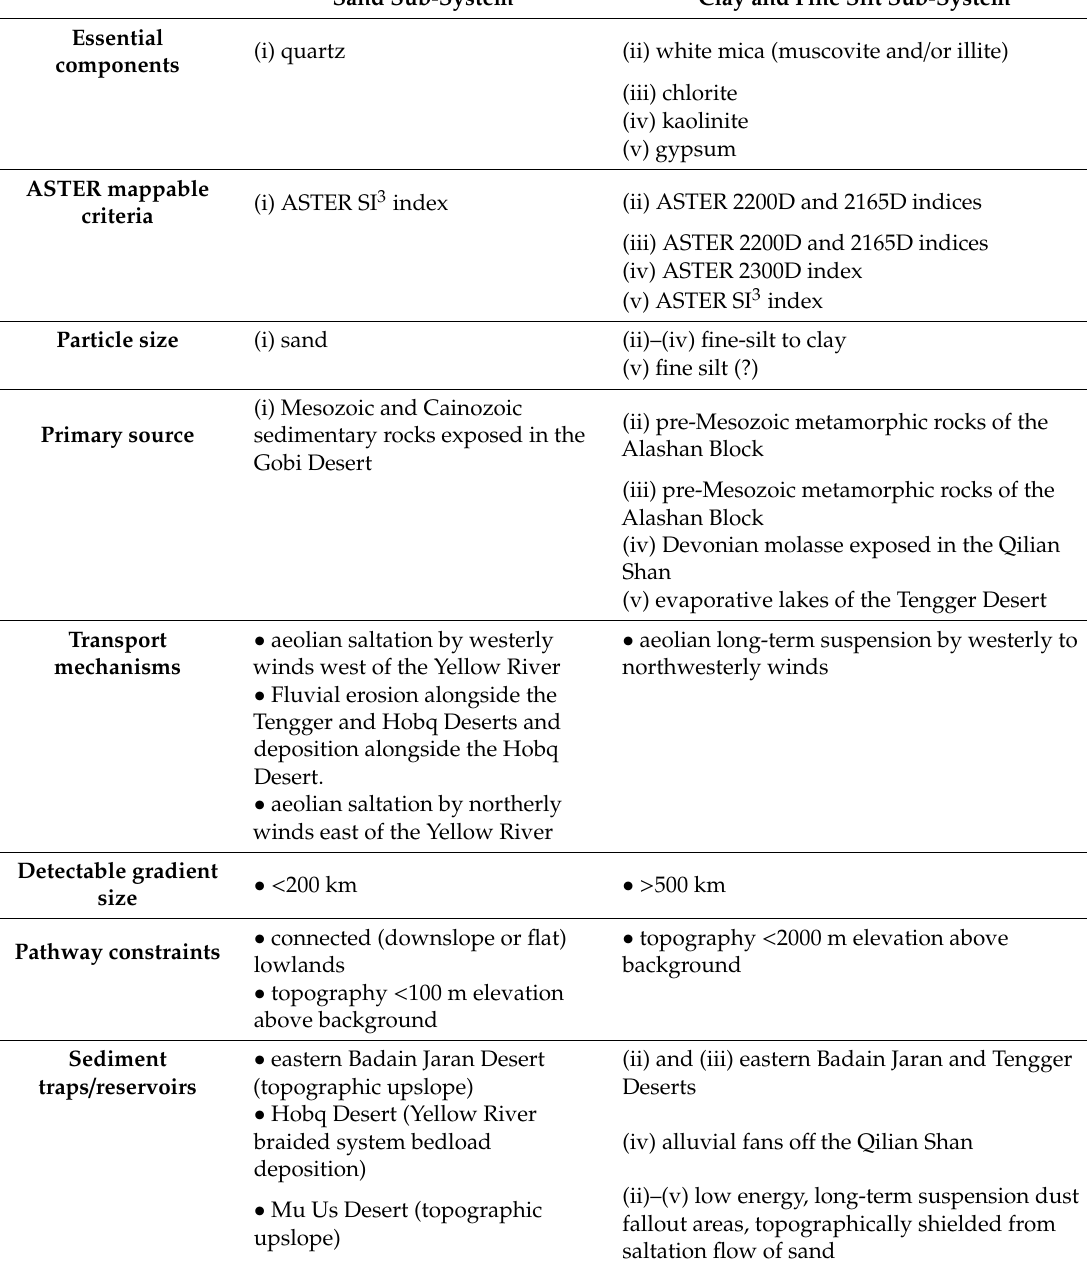
Table 1. A mineral-based “loess system” sediment transport model using ASTER satellite